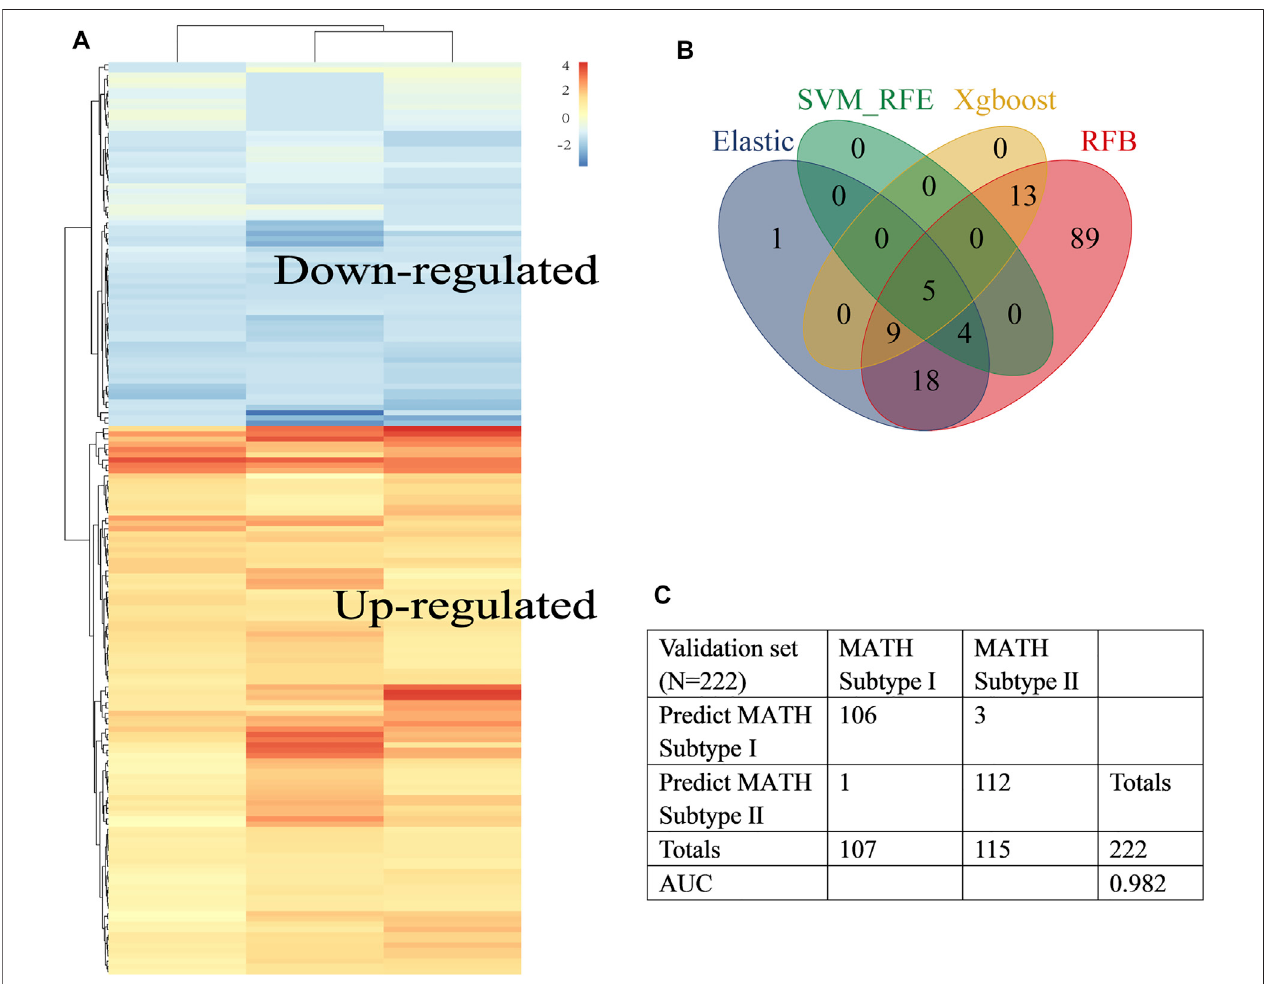
FIGURE 2 | Construction of the early-stage LUAD diagnosis model. (A) Heat map showed differentially expressed genes in tumor tissues (abs logFC > 1, fdr < 0.05) identi fi ed by RRA. Rows represent DEGs and columns represent different datasets. (B) Venn diagram identi fi ed fi ve diagnosis genes shared by ElasticNet, SVM-RFE, RFB, and XGBoost machine learning. (C) . Confusion matrix of binary result of the diagnosis model for the internal validation cohort.